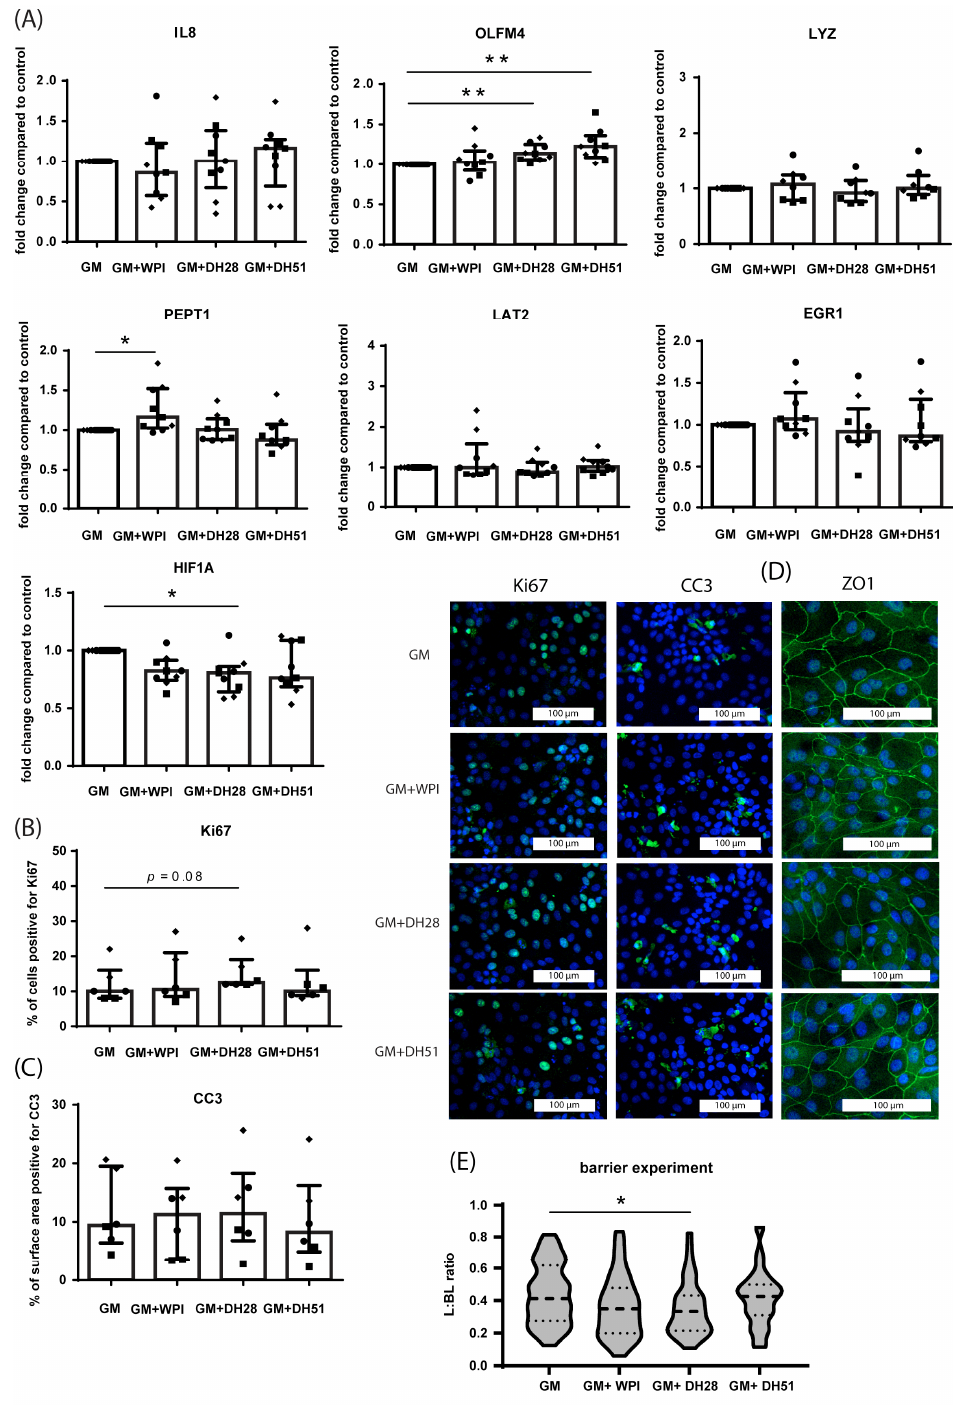
Figure 8. Effect of WPI, DH28, and DH51 on crypt-like HIO (monolayer- and 3D-cultured) in a diseased setting (hypoxia). ( A ) mRNA expression of IL8 (pro-inflammatory cytokine), OLFM4 (stem cells), LYZ (Paneth cells), PEPT1 (di/tri-peptide transporter), LAT2 (amino acid transporter) and HIF1A (hypoxia-regulated transcription factor) in crypt-like HIO monolayers exposed to hypoxia (24 h) and WPI, DH28, or DH51 (24 h) compared to control. Data are reported as relative